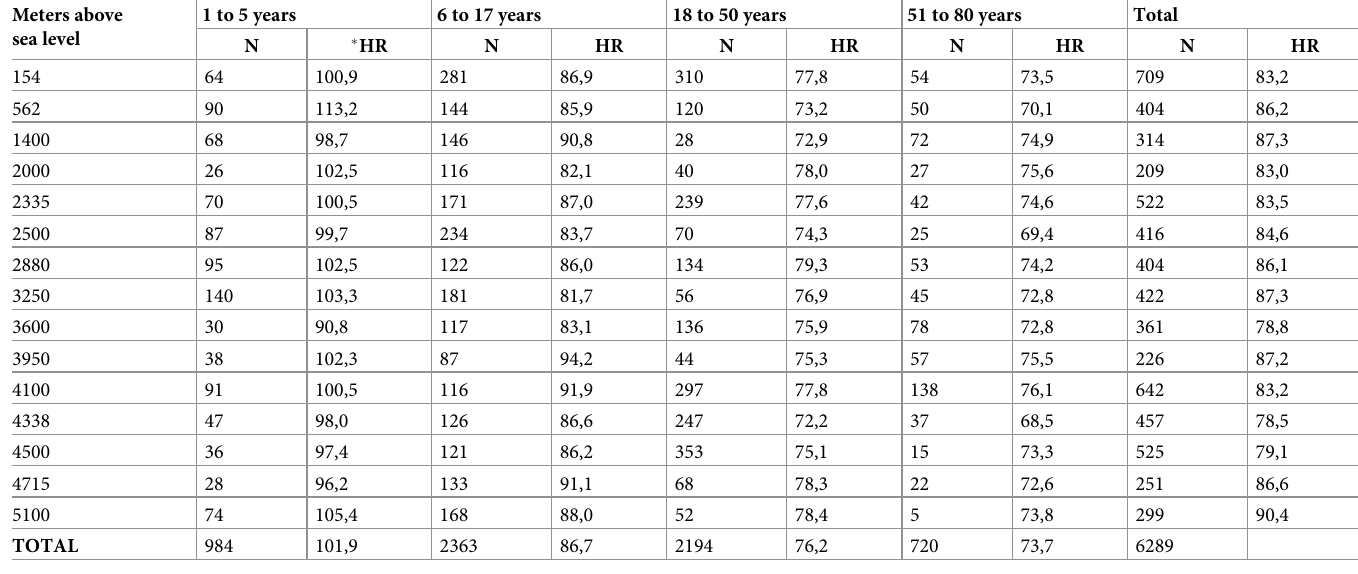
Table 1. Heart rate values by altitude and age range, in inhabitants at different altitudes. Meters above sea